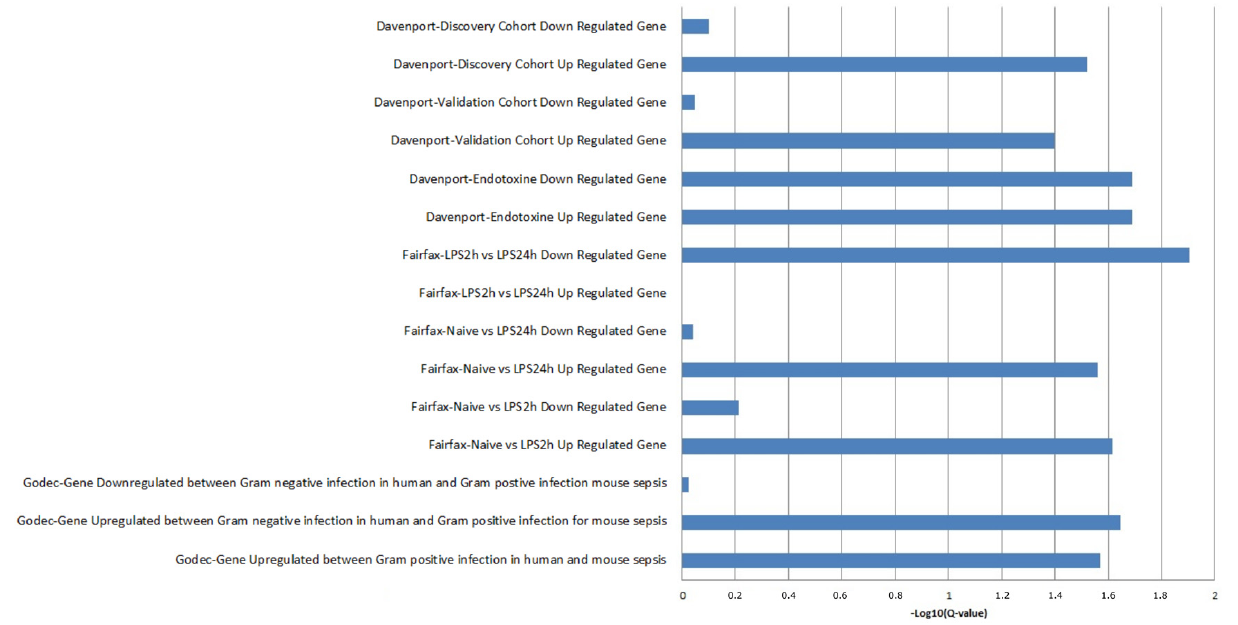
Figure 7. Plot of -log10 (Q-value) of gene set enrichment analysis for GSEA analysis.